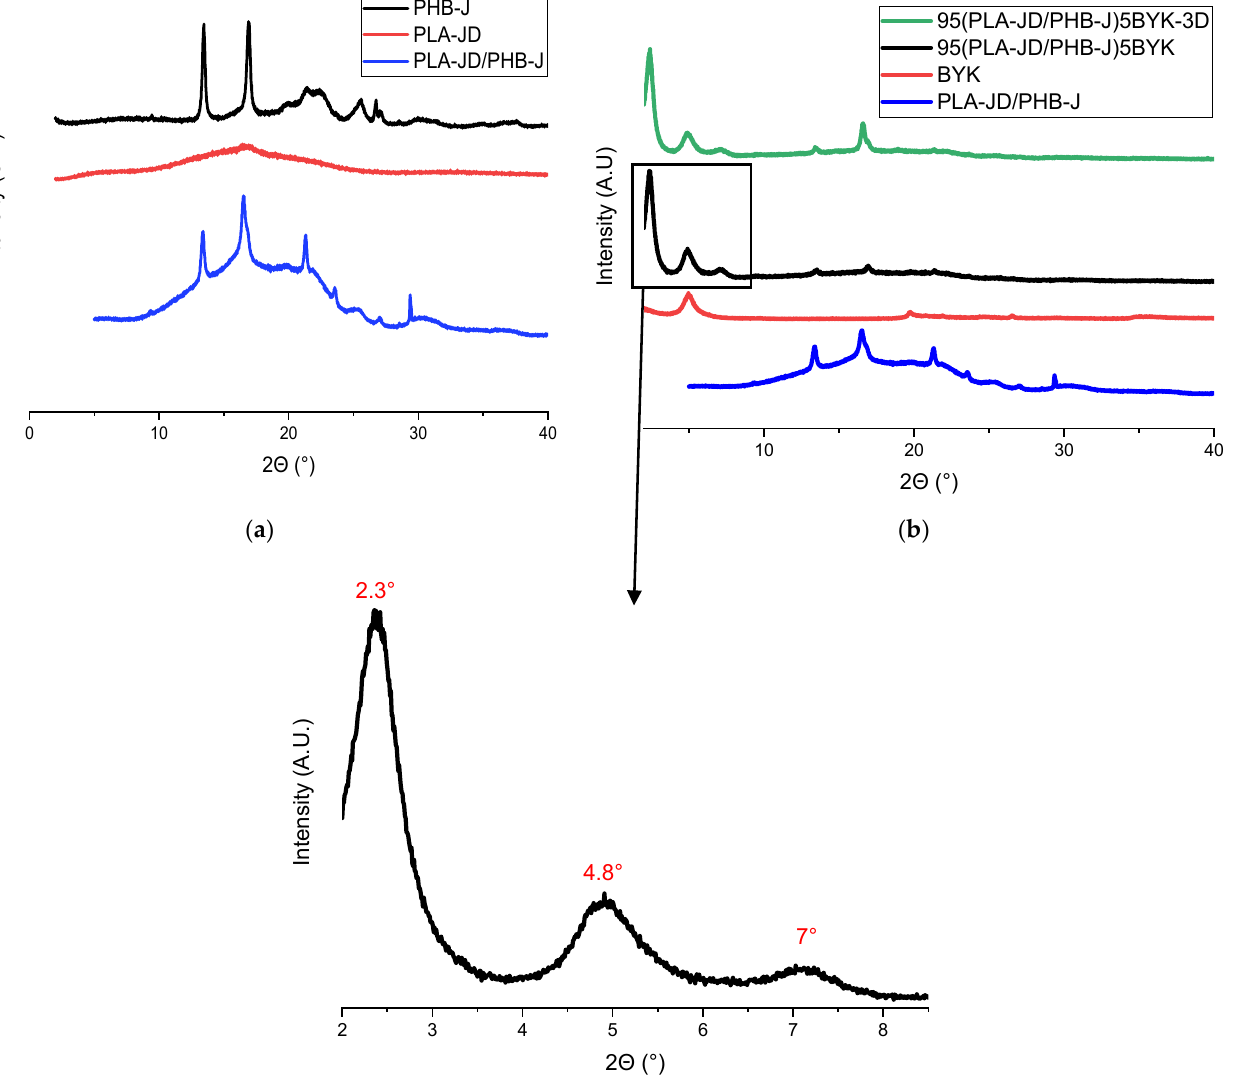
Figure 2. XRD patterns of ( a ) neat PLA-JD, neat PHB-J, and PLA-JD/PHB-J blends processed by injection molding; ( b ) clay and PLA-JD/PHB-J with and without clay processed by injection molding, and 95(PLA-JD/PHB-J)5BYK-3D processed by 3D printing.